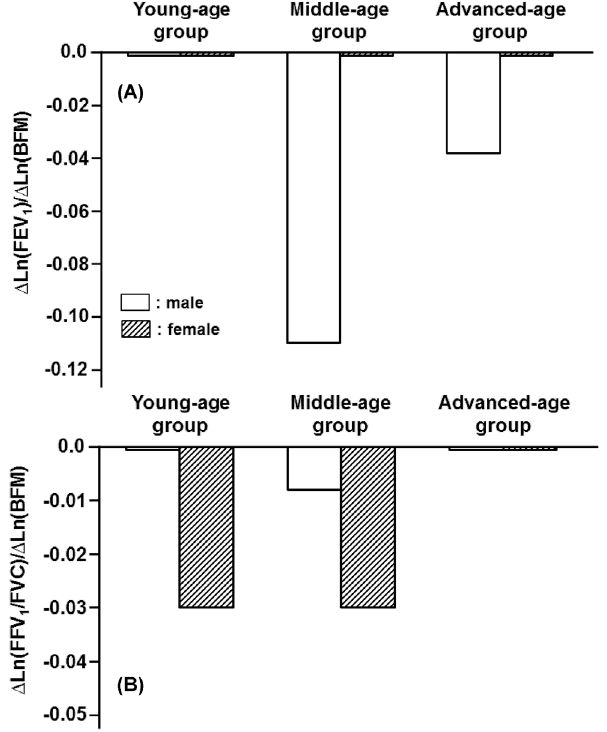
Figure 8. Age-specific impacts of body fat mass (BFM) on deciding FEF 50 and FEF 75 estimated for three different age groups of male and female participants. (A): Partial regression coefficients of Ln(BFM) for reference means of Ln(FEF 50 ) in young-, middle-, and advanced-age groups of either gender. They are expressed as D Ln(FEF 50 )/ D Ln(BFM). (B): Partial regression coefficients of Ln(BFM) for Ln(FEF 75 ) are defined as D Ln(FEF 75 )/ D Ln(BFM).